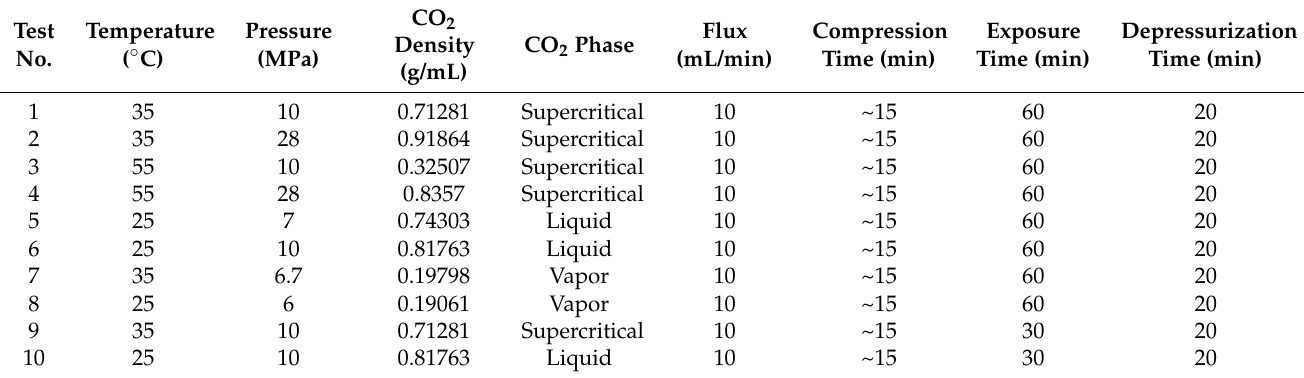
Figure 1. ( a ) Schematic diagram showing the apparatus used for trials: (1) CO 2 cylinder, (2) refrigeration unit, (3) high-pressure pump, (4) check valve, (5) pressure transducer, (6) thermostatic bath, (7) temperature controller, (8) high-pressure cell with sapphire windows, (9) cell support, (V1) to (V6) high-pressure valves. ( b ) Poly(methyl methacrylate) (PMMA) samples on a stainless-steel grid support inserted in the stainless-steel cell. Table 1. Summary of experimental conditions used for CO 2 trials on poly(methyl methacrylate) (PMMA).